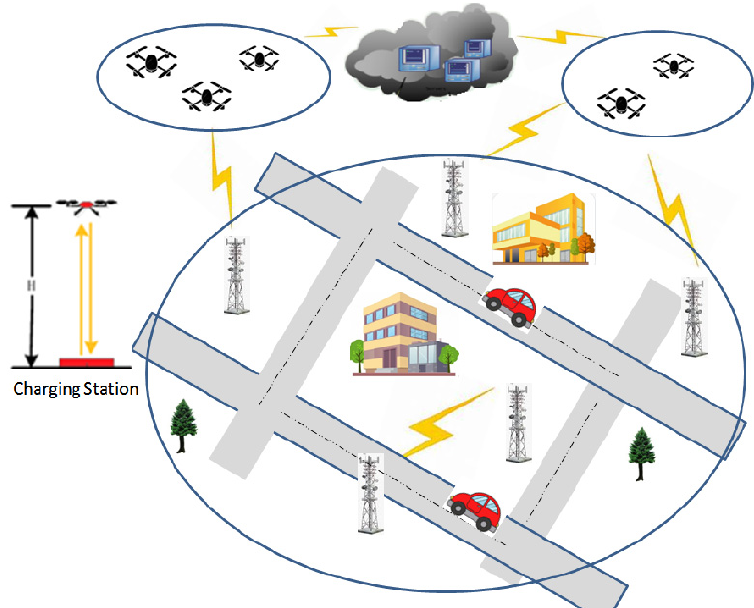
Figure 9. Multiple layers of the airspace with high-precision positioning.